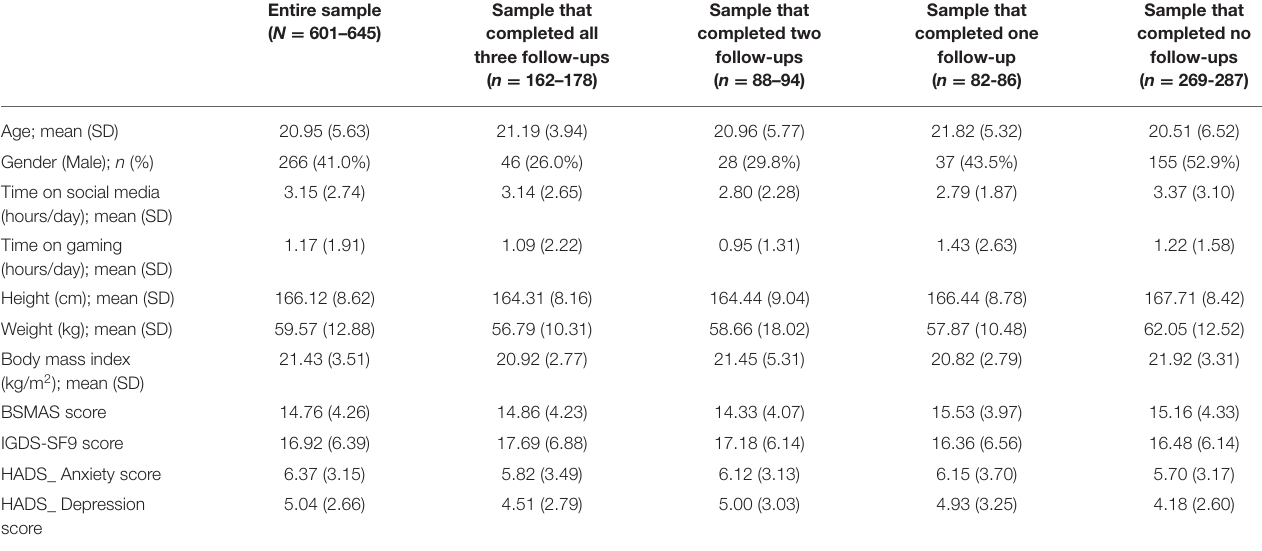
TABLE 1 | Participant characteristics.